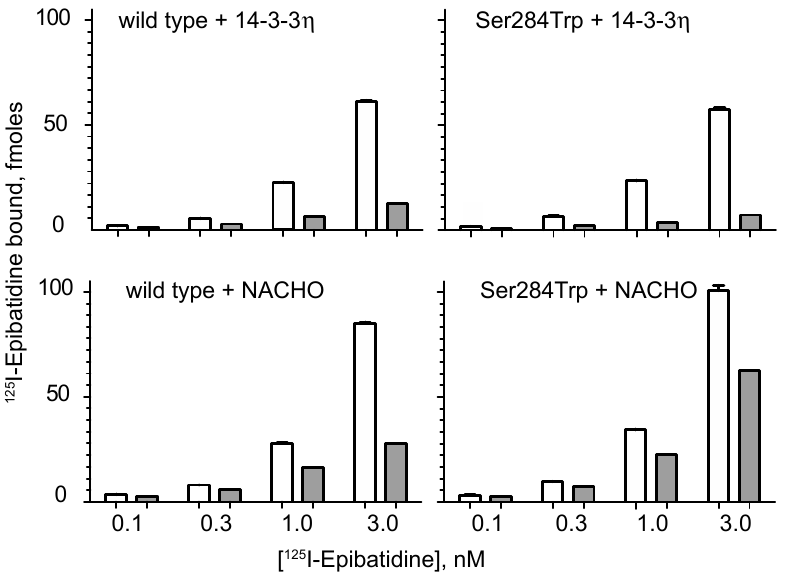
Figure 3. Expression of wild type and α 4-Ser284Trp nAChRs in Bosc 23 cells. Cells were transfected with cDNAs encoding the wild type or mutant α 4 subunit plus the β 2 subunit and the indicated chaperone, either 14-3-3 η or NACHO. Suspensions of intact cells were prepared, incubated with the indicated concentrations of 125 I-epibatidine, and radio-ligand bound to the cells was determined as described in Materials and Methods. Open bars represent duplicate measurements of specific binding of 125 I-epibatidine alone, whereas gray bars represent binding in the presence of 6 mM ACh. Each determination represents binding to one tenth of the cells harvested from a 10 cm tissue culture dish. Error bars larger than a line width indicating the SD are